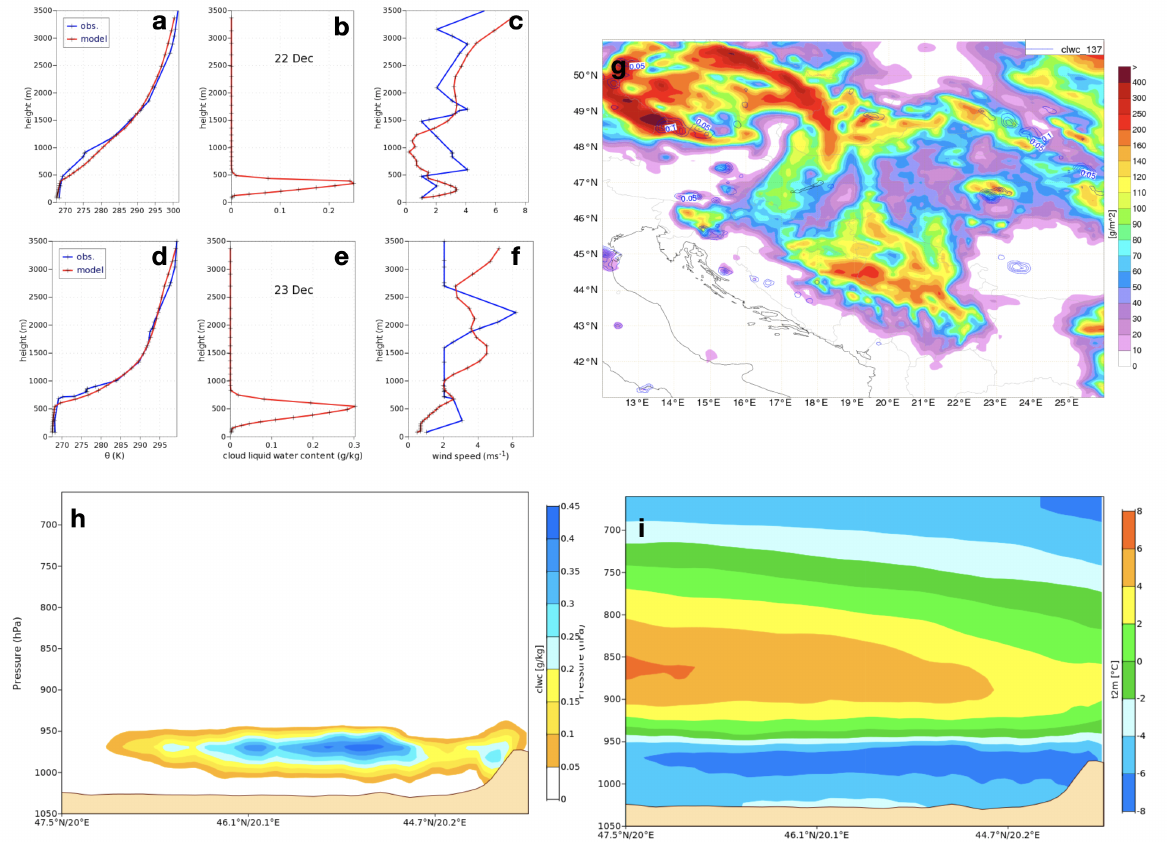
Figure 9. Winter stratocumulus and fog-covered cold air pool (22–24 December 2016): ( a ) radiosounding (blue) and ECMWF profile (red) at Szeged Airport at 00 UTC (blue) for potential temperature, ( b ) water vapour mixing ratio, ( c ) wind speed at 00 UTC of 22 December; ( d – f ) similarly for 00 UTC of 23 December; ( g ) maximal extension of the Sc deck at the end of the fog event (24 December 2016, 06 UTC) showing the integrated cloud water for the lower 600 m of the atmosphere; ( h ) vertical cross-sections of cloud water along the Tisza valley reaching the Dinarides of cloud water on 23 December at 00 UTC; ( i ) similarly for